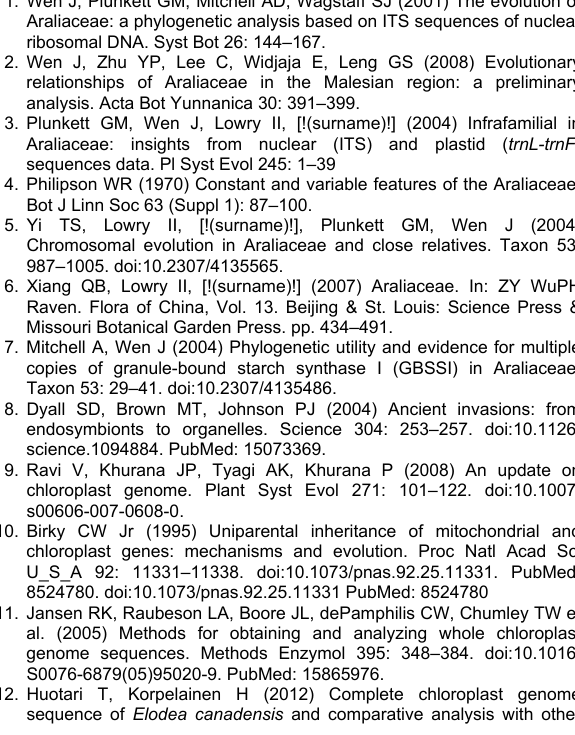
Table S4. Summary statistics for candidate regions in the chloroplast genomes of